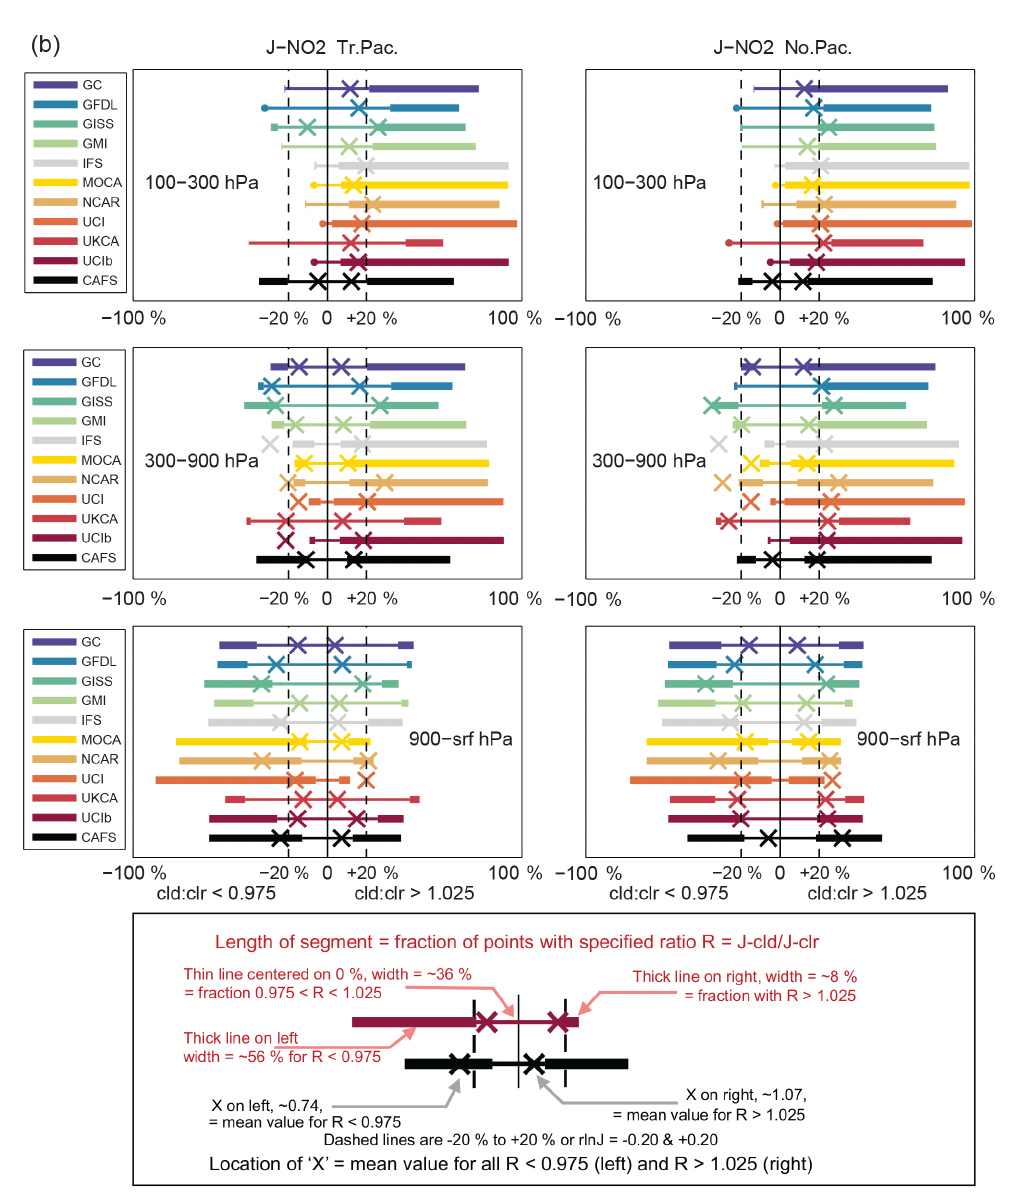
Figure 5. (a) Frequency of occurrence and magnitude of change in J -O1D caused by clouds. The panels and data sources are the same as in Fig. 4ab. The horizontal lines all have length 1 and show the fraction of (i) cloud-diminished J s (thick left segment, cloudy:clear ratio<0.975), (ii) nearly cloud-free J s (thin central segment, 0.975<ratio<1.025), and (iii) cloud-enhanced J s (thick right segment, ra- tio>1.025). Each line is plotted with its nearly cloud-free segment centered on 0. The mean magnitude of diminishment/enhancement corresponding to the thick line segments is plotted as an “X” on each line segment, using the x axis [ − 1, + 1] as the natural log of the cloudy:clear ratio. Ratio changes of − 20% and + 20% are shown as dashed vertical grid lines. The Xs are not shown when the frequency of occurrence of either thick segment is <0.02. For an example of how to read these figures consider the panel in row 3 column 1 ( J -O1D, Tr. Pac, 900–srf). The GFDL model has about 22% cloud-diminished J s (left segment) with an average value of 22% below clear-sky J s (the X on the left side); most of the remaining, 76%, are nearly cloud-free (central thin segment). The GISS model has (from left to right) 42% cloud-diminished J s, 53% cloud-free J s, and only 5% cloud-enhanced J s for a total of 100%; the cloud-diminished J s average about 28% less than clear-sky J s (the X on the left) while the cloud-enhanced J s average about 22% greater (the X on the right side). See legend in Fig. 5b. (b) Frequency of occurrence and magnitude of change caused by clouds in J